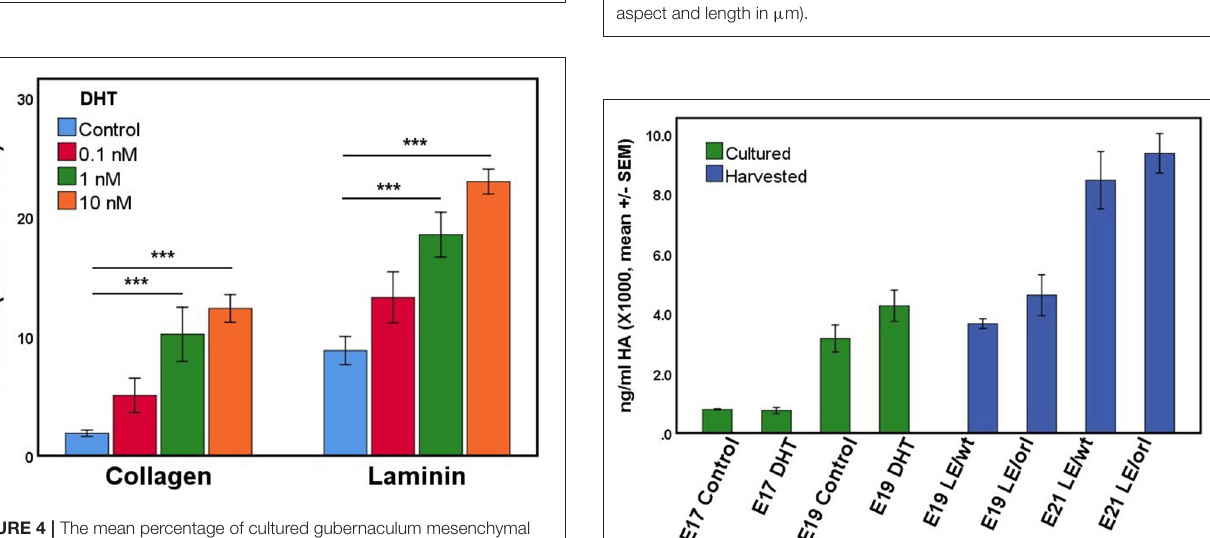
FIGURE 4 | The mean percentage of cultured gubernaculum mesenchymal cells expressing AR ( n = 6 per exposure group) is enhanced by DHT in a dose- and substrate-dependent manner (original magnification, 40X; *** p < 0.001).